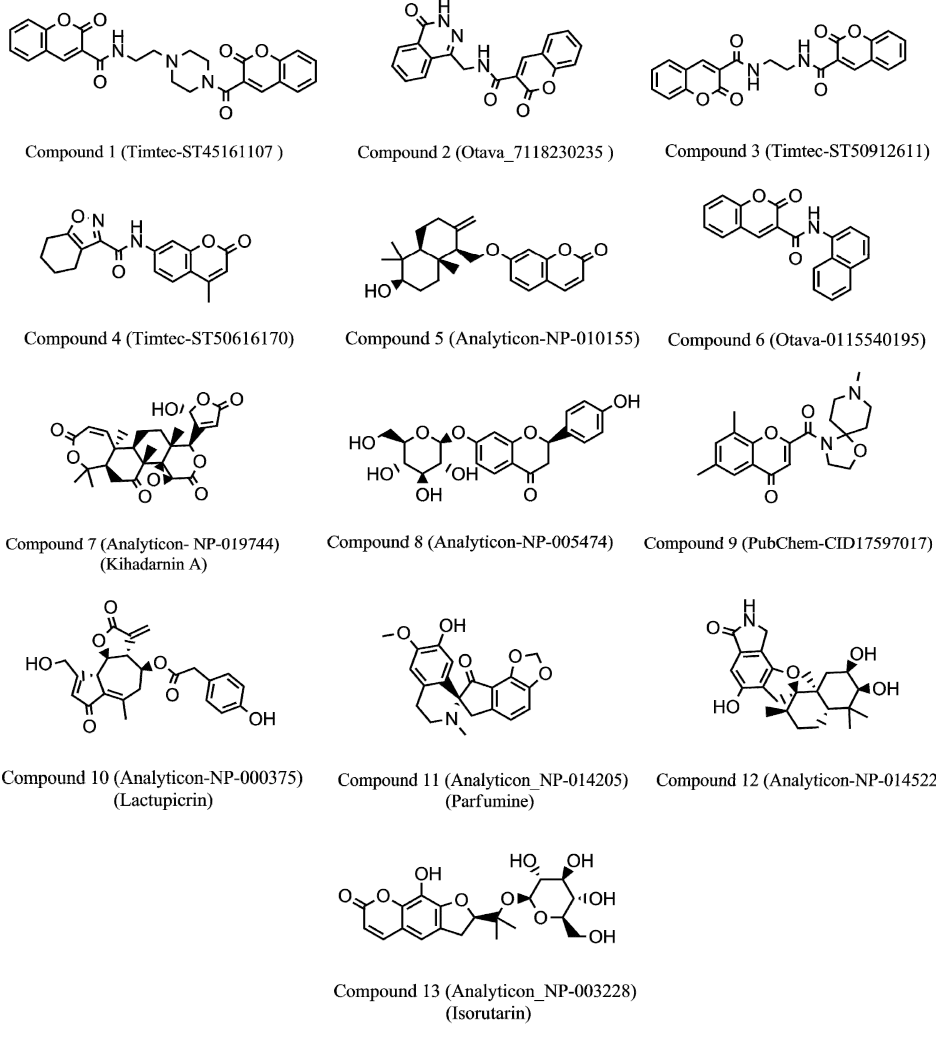
Figure 2. Chemical structures of virtual hits are represented in 2D format.